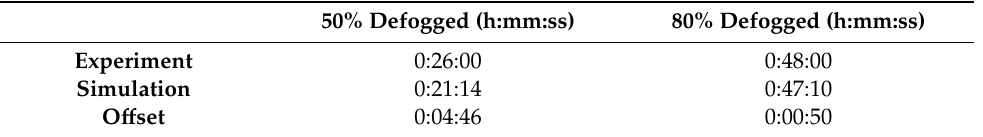
Table 6. Time comparison of the defogging duration in